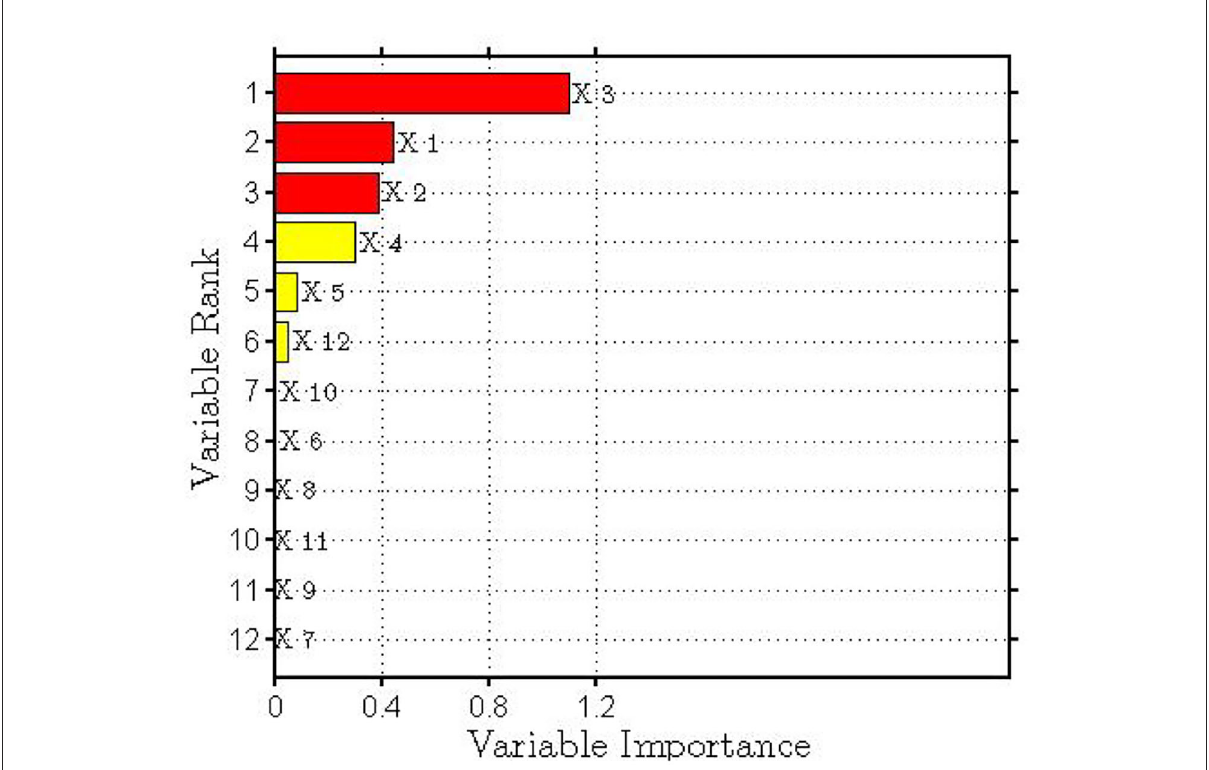
FIGURE3 The importance of online behavior